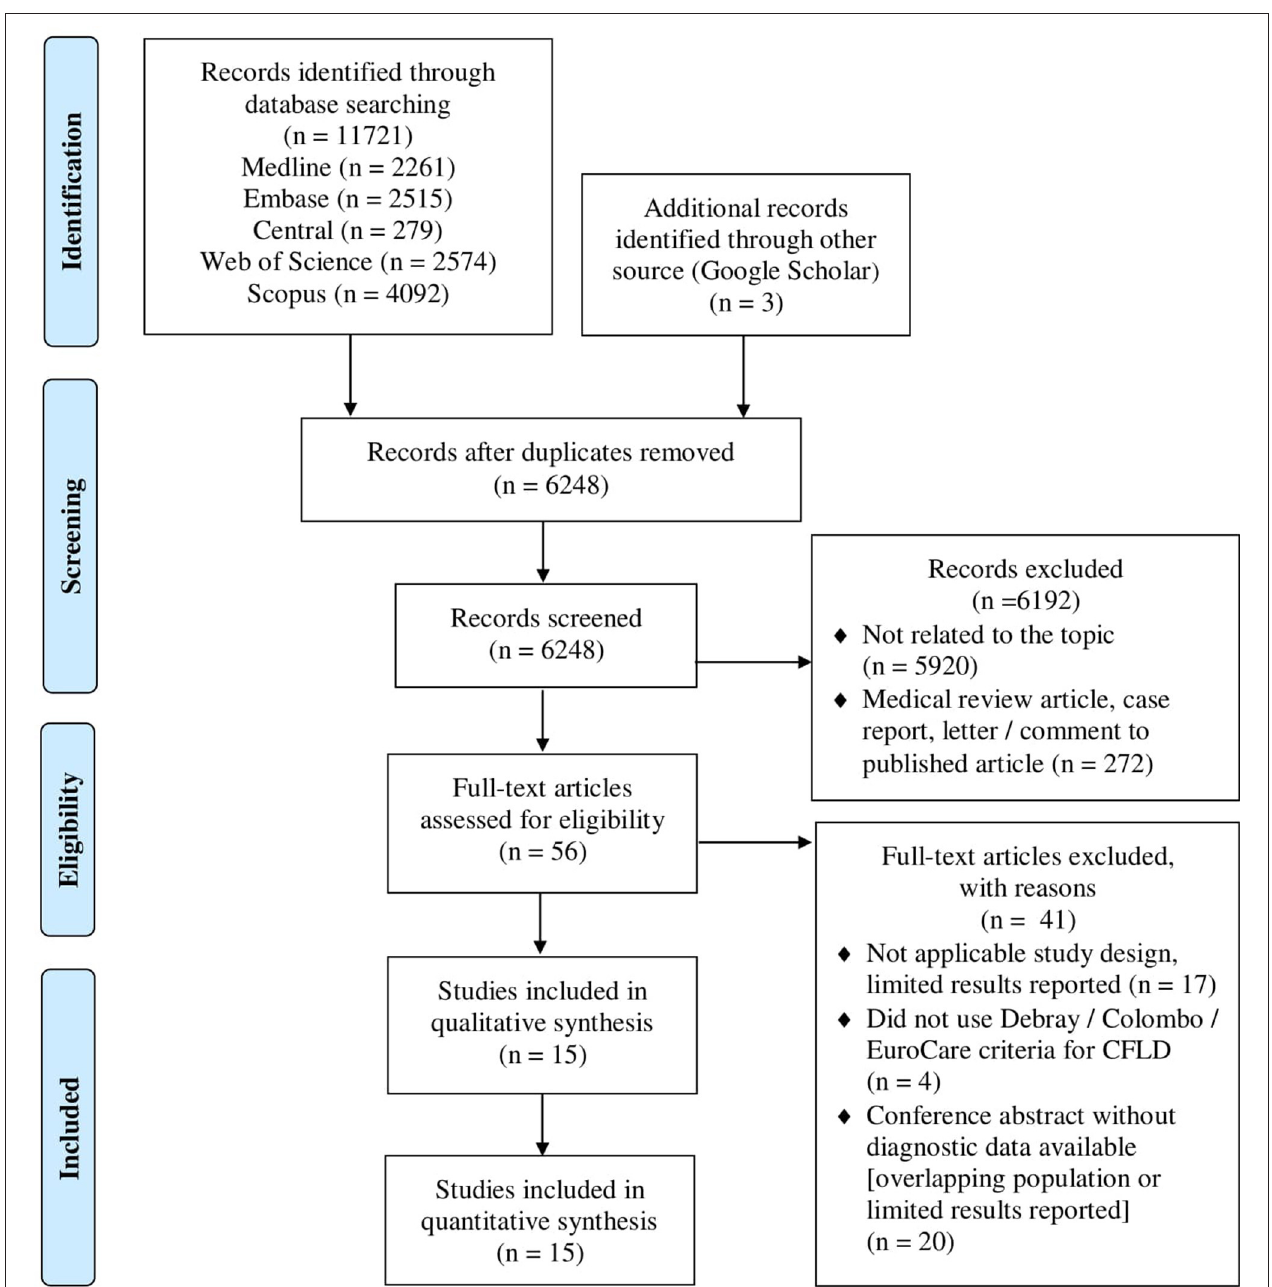
FIGURE 1 | PRISMA 2009 flow diagram of the study selection. The algorithm for the study selection; out of 11,721 records, 13 full-text articles and two conference abstracts were included in the final analysis.